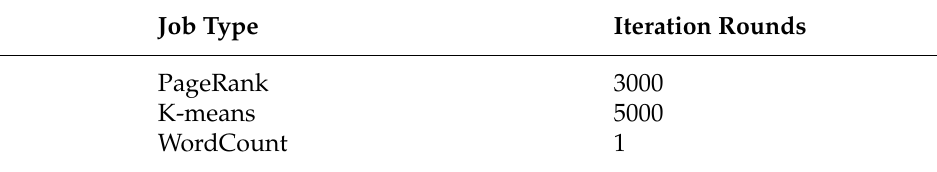
Table 2. Benchmark